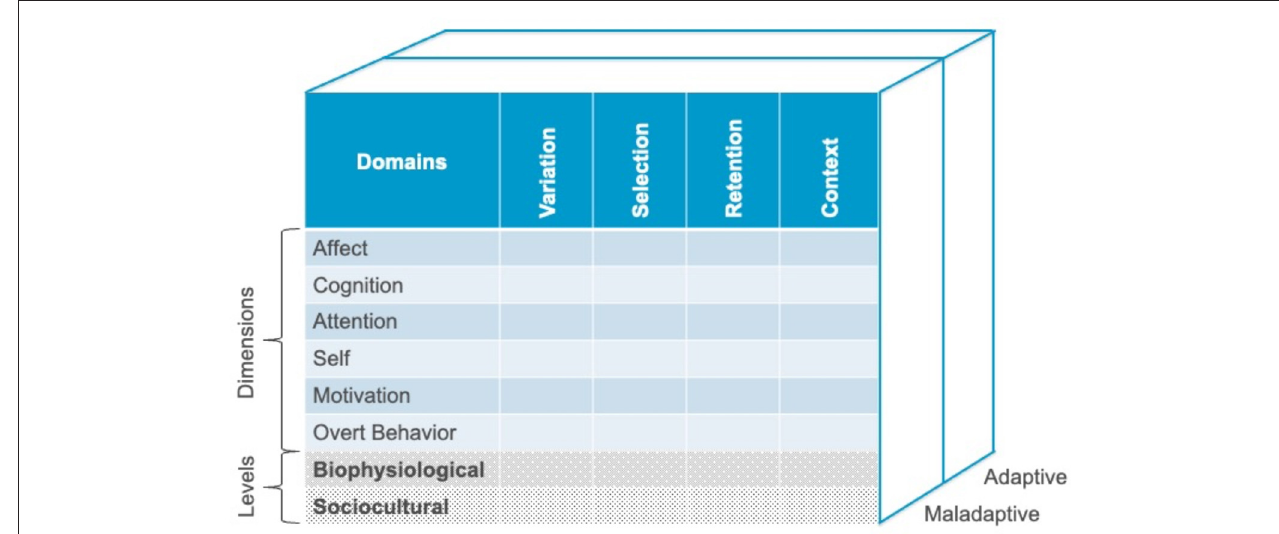
FIGURE 1 | A conceptual space for the examination of adaptive and maladaptive change processes, based on modern multi-dimensional, multi-level evolution science. Copyright Steven C. Hayes, Stefan G. Hofmann, and Joseph Ciarrochi. Used by